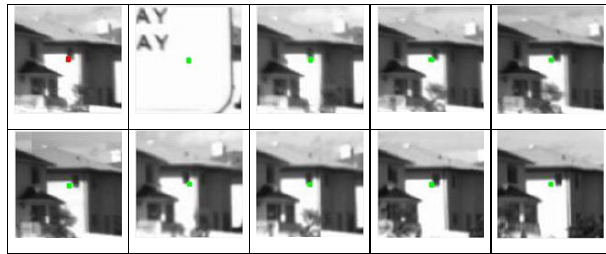
Figure 17. Incorrect matching result is shown on computer’s